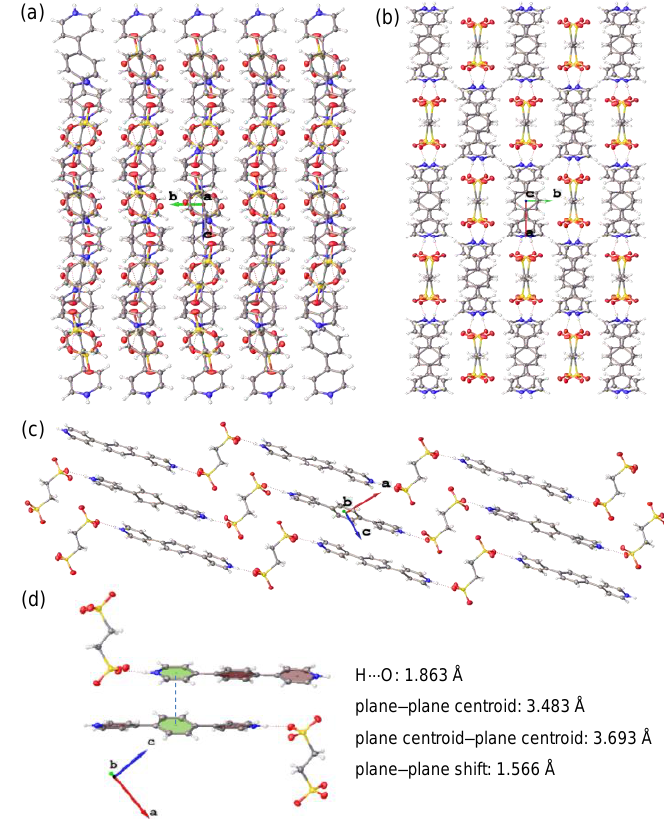
Figure 4. ( a – c ) Molecular packing of the single crystal of 6 viewed from the ( a ) a , ( b ) c , and ( c ) b axis, respectively. ( d ) Molecular stacking with potential π∙∙∙π interaction of 6 .